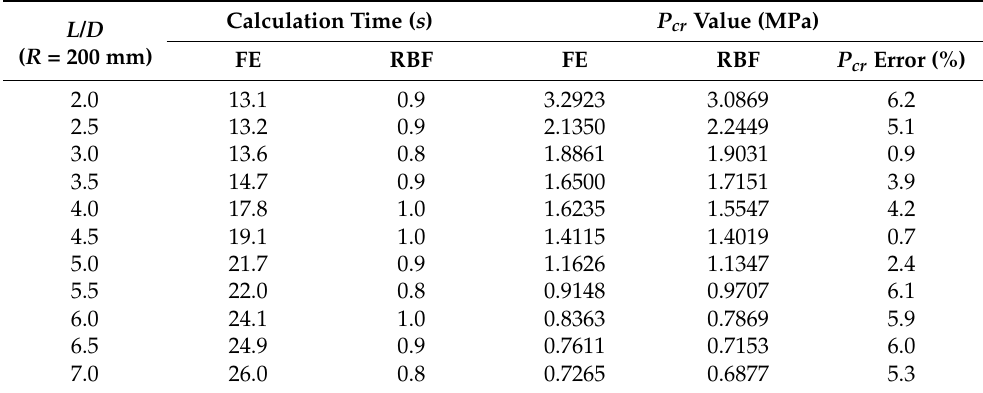
Table 4. Calculation efficiency ( T 0 = 60 ◦ and T 1 = 15 ◦